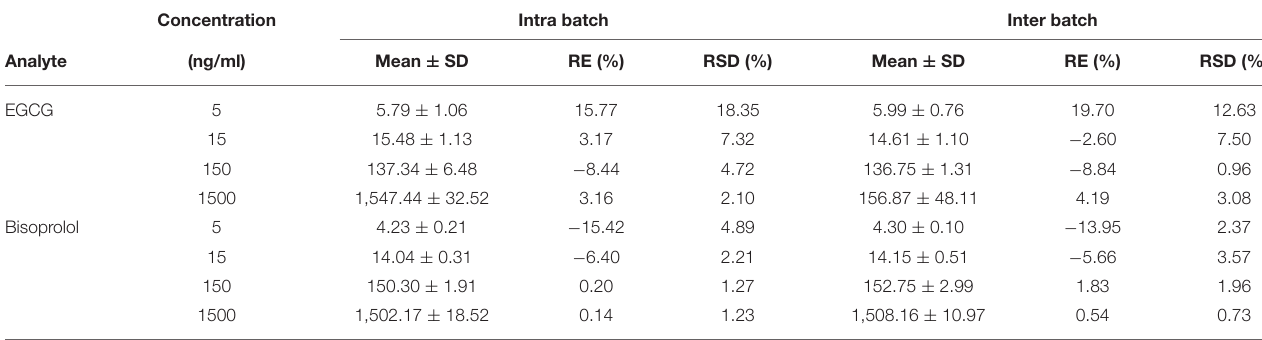
TABLE 2 | Intra-day and inter-day precisions and accuracies for the determination of EGCG and Bisoprolol from the assay samples (mean ± SD, n = 6). Concentration Intra batch Inter batch Analyte